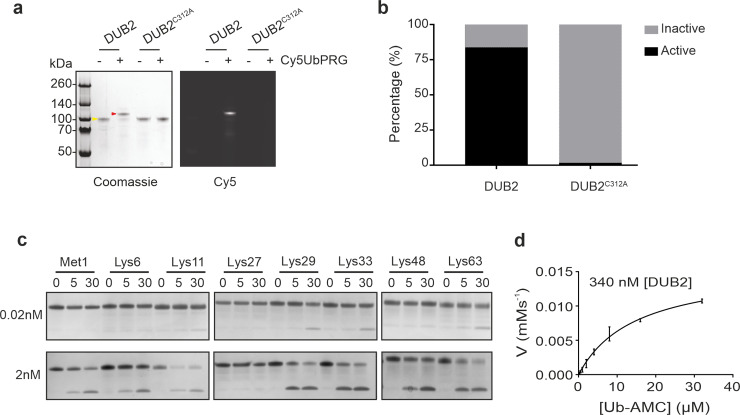
In vitro characterization of DUB2 recombinant protein.(A) 500 ng of purified DUB2 and DUB2C312A were incubated with or without 1.2 μg of Cy5UbPRG for 30 min. Samples were analysed by SDS-PAGE gel electrophoresis with in-gel fluorescence (Cy5). The gel was stained in InstantBlue protein stain. The yellow arrowhead indicates DUB2 and the red arrowhead shows DUB2 in complex with the Cy5UbPRG probe. (B) The stained gel in (A) was analysed using GelAnalyzer 19.1 software to determine the band intensity for DUB2 and DUB2 in complex with the ABP. Data were then collected and analysed to determine the ratio between the active and inactive form of DUB2 in Prism software. (C) Different di-ubiquitin linkage types were incubated with recombinant DUB2 (0.02 nM or 2 nM) for the times indicated and proteins resolved by SDS-PAGE gel and stained with InstantBlue Protein Stain. (D) Michaelis-Menten kinetic analysis for DUB2 hydrolysis of Ub-AMC. Error bars represent s.d. from the mean. Reactions containing 400 nM DUB2 were initiated by the addition of Ub-AMC at final concentrations between 0.25 μM and 32 μM. Assays were performed in triplicate for three independent experiments. Initial rates were determined by calculating the gradient of a linear regression of the product concentration against time (from 0–400 sec).